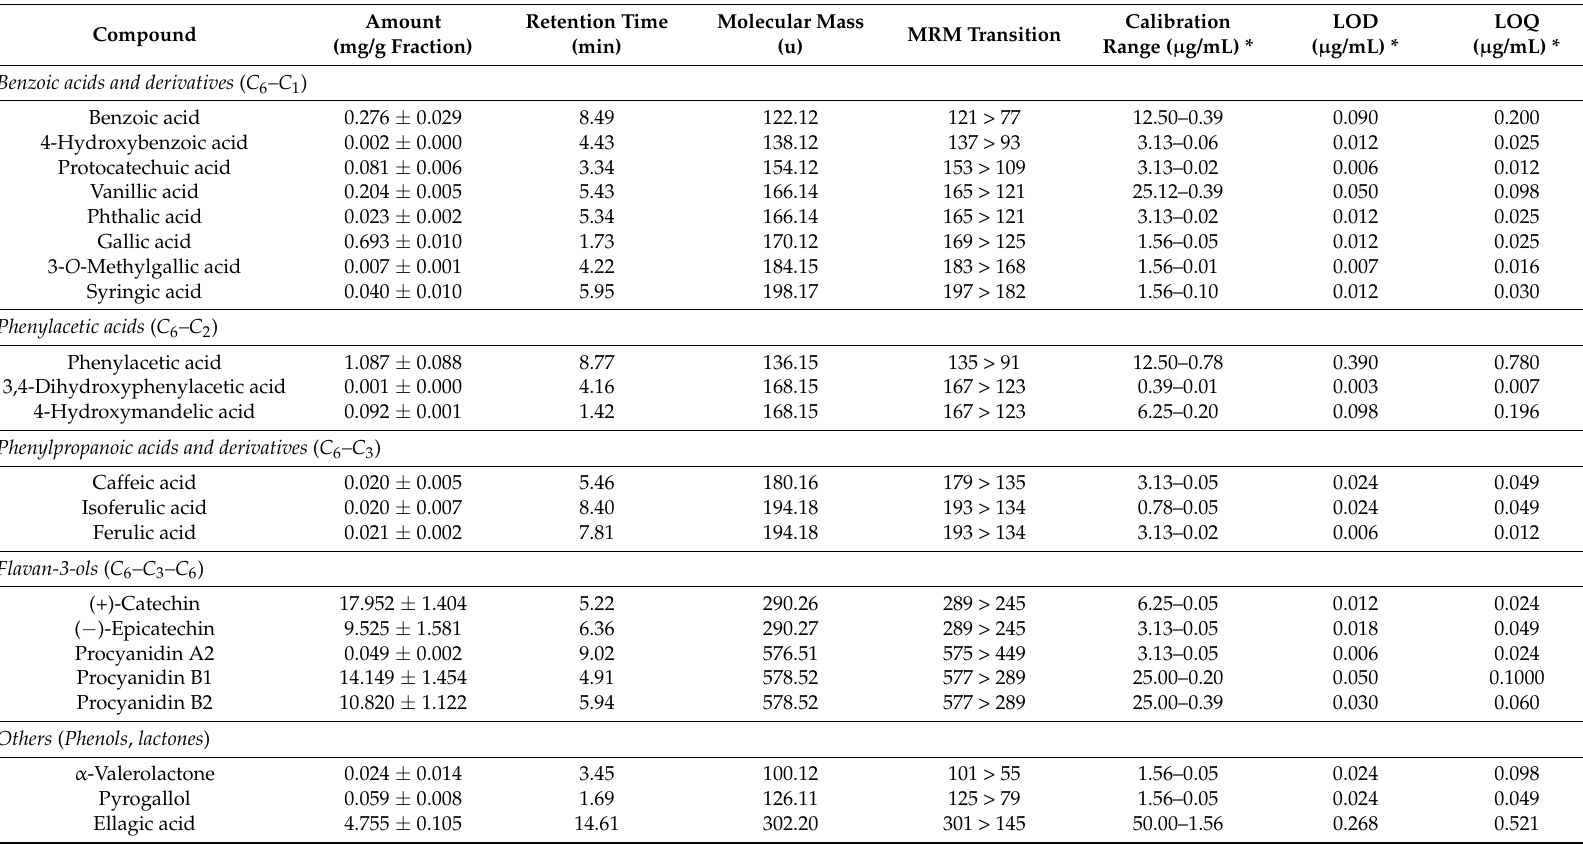
Table 2. Identification and quantitation of phenolic compounds in F.AcOEt fraction of P. friedrichsthalianum fruit by UHPLC-ESI/QqQ (negative